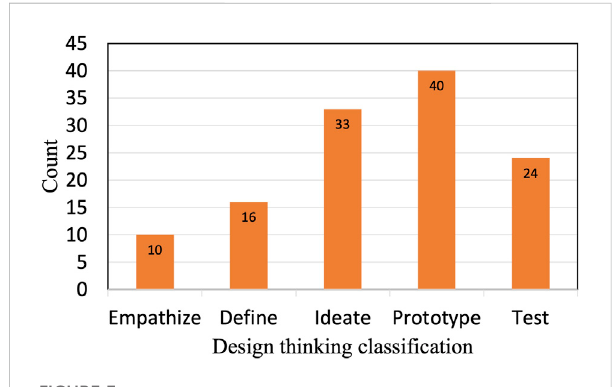
FIGURE 3 Classi fi cation of publications based on 5 design-thinking